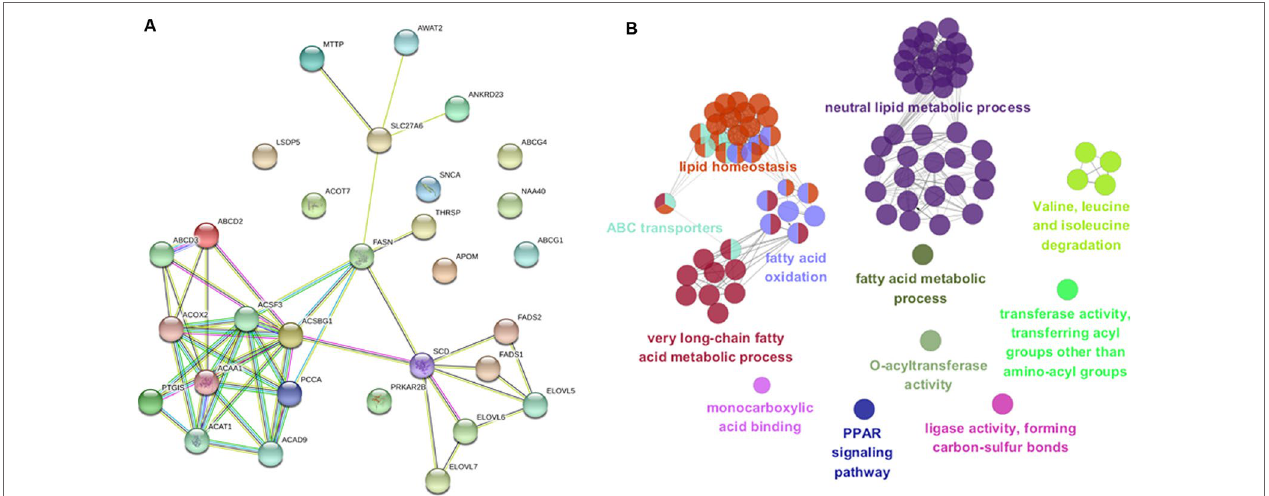
FIGURe 6 | Protein-protein interaction network and gene ontology enrichment analysis of candidate genes. (A) Protein-protein interaction network of the 32 most plausible candidate genes of the lead SNPs detected by GWAS and meta-analysis in STRING v10.5 database. (B) Gene ontology enrichment analysis of candidate genes. Over-represented GO/pathway terms were grouped based on kappa statistics. GO/pathway terms are represented as nodes, and the node size represents the term enrichment significance, while the edges represent significant similarity between categories.